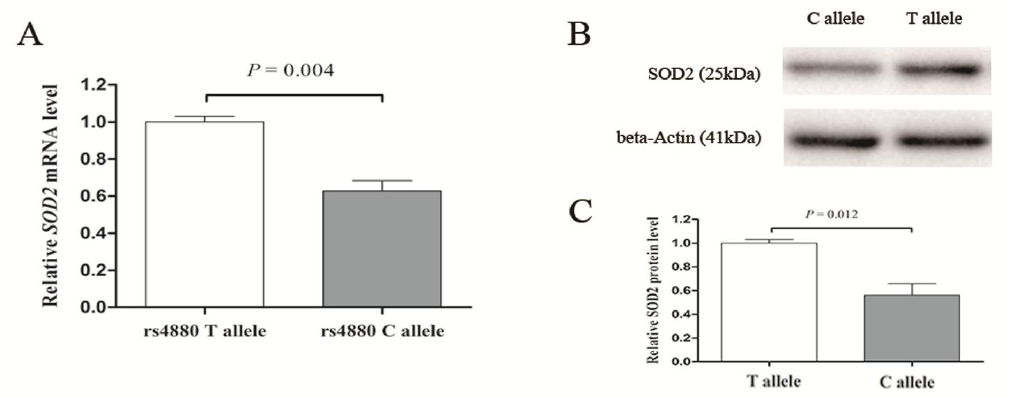
Figure 1. SOD2 expression levels of rs4880 different variants. ( A ) SOD2 mRNA expression; ( B ) SOD2 protein expression; ( C ) Gray scale analysis of (B).